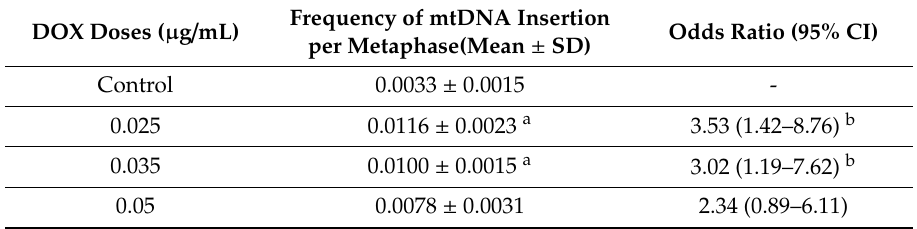
Table 1. Cytogenetically visible mtDNA insertions in metaphase chromosomes of human leukocytes and their association with DOX treatment.